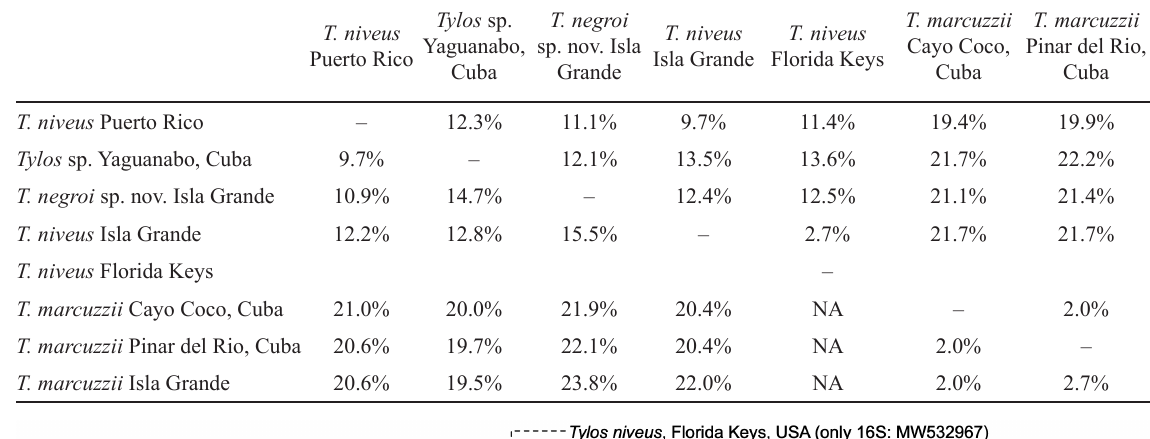
Table 2. Genetic p -distance for 16S rDNA (above the diagonal) and 12S rDNA (below the diagonal) between the main genetic lineages of Tylos Audouin, 1826 in the Caribbean and